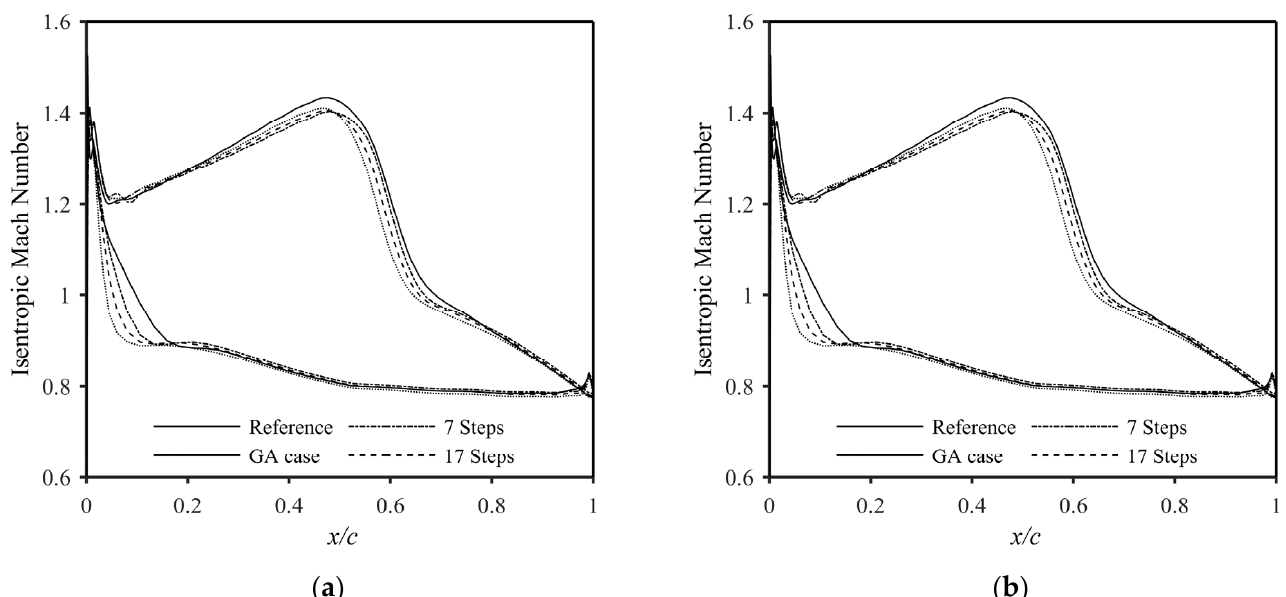
Figure 18. Isentropic Mach number distribution through the chord line at spans of 70% and 90%: ( a ) 70% span; ( b ) 90% span.